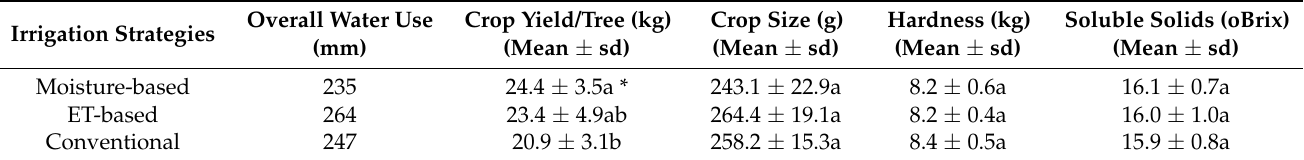
Table 1. The evaluation of three irrigation